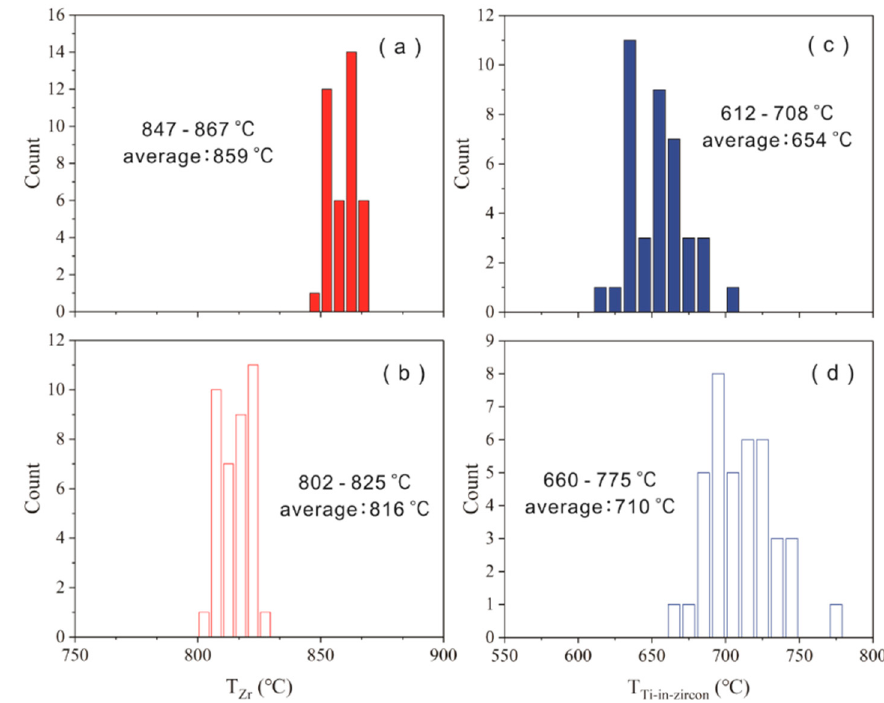
Figure 12. Histograms of zircon saturation thermometry (T Zr ) and Ti-in-zircon thermometry (T Ti-in-Zircon ) for Muchen quartz monzonite (LY-8). ( a ) Calculated by Boehnke et al. [89]; ( b ) Calculated by Watson and Harrison. [86]; ( c ) Calculated by Watson et al. [87]. ( d ) Calculated by Ferry and Watson. [90].